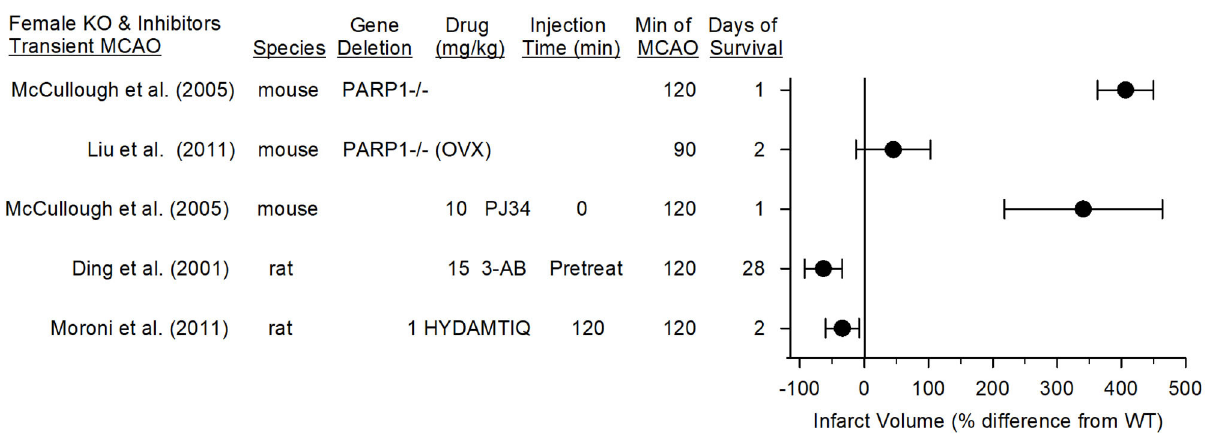
FIGURE 6 | Effect sizes and 95% confidence intervals on infarct volume after transient middle cerebral artery occlusion (MCAO) in female PARP1 − / − mice and female mice treated with a PARP inhibitor, relative to their respective controls, were derived from mean and SD values and sample sizes extracted from publications by McCullough et al. (70), Liu et al. (71), Ding et al. (107), and Moroni et al. (89). On a percentage basis, the large increase in infarct volume in PARP1 − / − mice is influenced by the small infarcts in the wild-type (WT) female mice. Ovariectimized (OVX) WT mice had larger infarcts than non-OVX WT mice, and the OVX PARP − / − mice did not have a significant increase in infarct volume compared to OVX WT